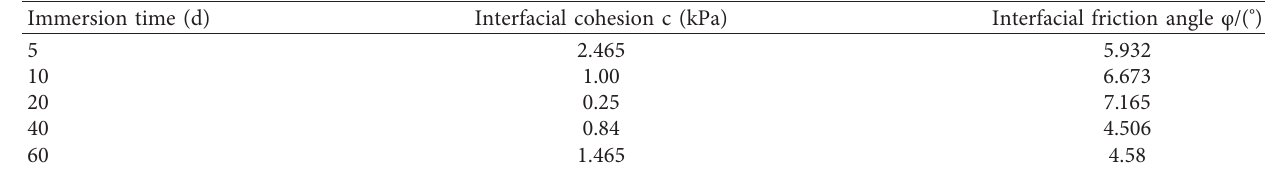
Figure 4: Interfacial shear strength curve under different immersion time. Table 3: Interface shear strength indexes under different immersion